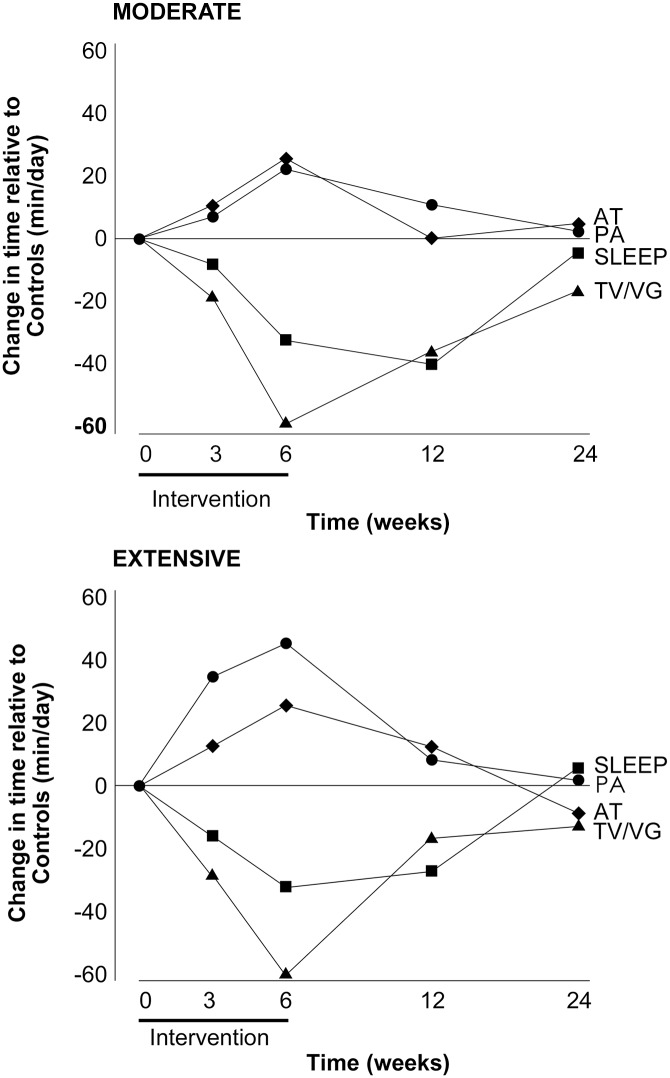
Changes in time from baseline to 6-month follow in the Moderate (top panel) and Extensive (bottom panel) groups, relative to Controls.
Note: AT = Active Transport, PA = Physical Activity, TV/VG = Television/Videogames.